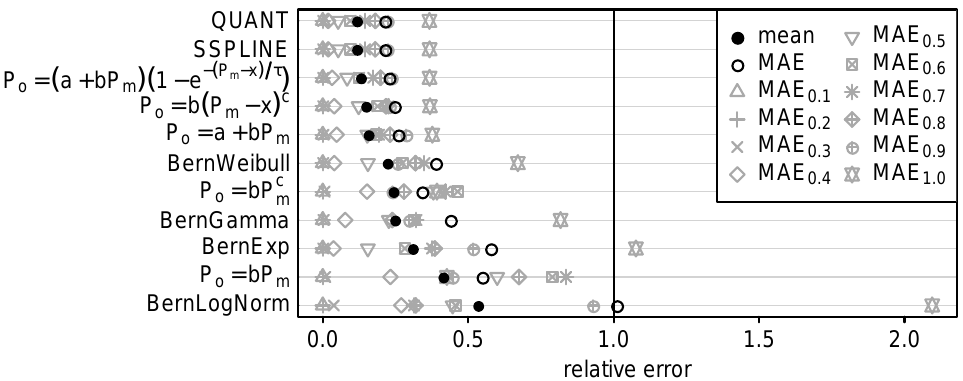
Fig. 4. Performance ranking of statistical transformations used for post-processing RCM output. Relative error (hollow symbols) is defined as the MAE of each method divided by the MAE of the uncorrected model output. The mean relative error (black dots) is used to rank the different